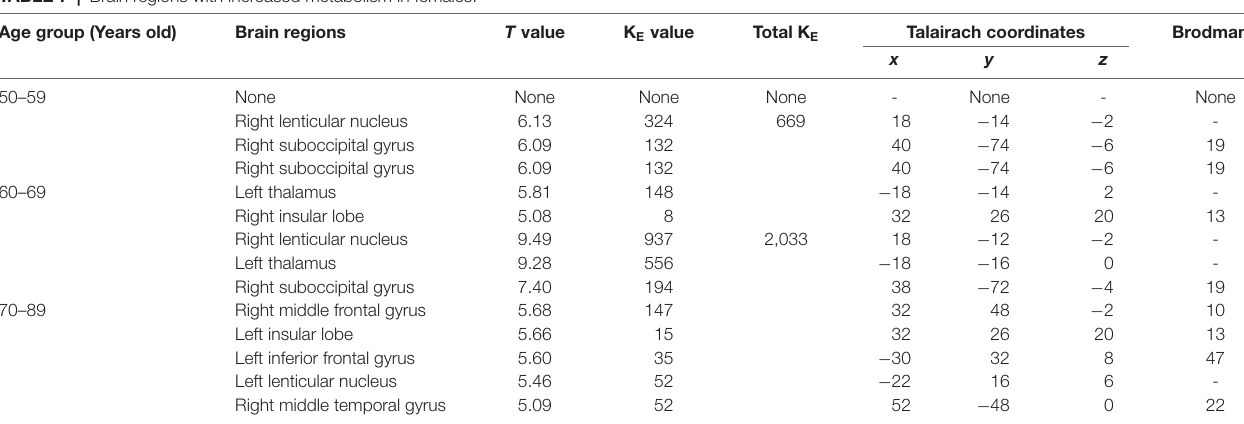
TABLE 7 | Brain regions with increased metabolism in females.